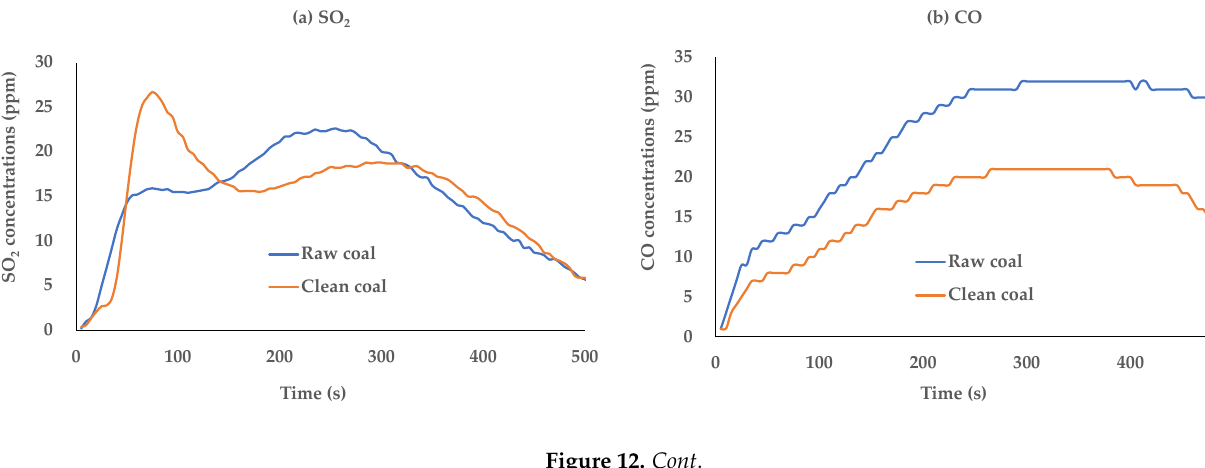
Figure 12. Air pollutant emissions of ( a ) the concentration of SO 2 ; ( b ) the concentration of CO; ( c ) the concentration of CO 2 ; ( d ) the modified combustion efficiency from the combustion of the raw coal and its clean coal using a dry coal cleaning system with two-stage corona electrostatic processes. 4. Conclusions The experimental results show that the factors of electrode voltage, drum rotational speed, and feedstock feeding speed of the corona separator had marked influences on the performance of the separation process, and this dry coal cleaning system with two-stage corona electrostatic processes can effectively reduce the ash content of the coal and per- forms much better than single-stage separation processes. Under the experimentally de- termined optimal parametric settings, the process can reduce ash content from 28.92% (raw coal) to 16.32% (clean coal) and sulfur content reduced from 4.71% to 3.53%. The sulfur content of the raw coal could not be further reduced because of organic sulfur as- sociated with clean coal and concentrated in clean coal, and no physical methods can ef- fectively remove this proportion of the organic sulfur. The combustion behavior of raw coal and the clean coal and the air pollutant emis- sions released from the combustion of the raw and clean coals were comparatively ana- lyzed. The results show that clean coal was a better fuel for combustion, the clean coal burned more completely and resulted in fewer CO emissions. This experimental study provides a simple and feasible approach to dry coal cleaning that is particularly well suited to preliminary coal cleaning in the power stations. Finally, this study has its limitations. Firstly, corona electrostatic separation is a phys- ical separate method, and the sub-method can only reject inorganic sulfur in raw coal, but not organic sulfur effectively, therefore, it is not effective for raw coals with high organic sulfur content. Secondly, because the charged properties of coal and ash vary significantly